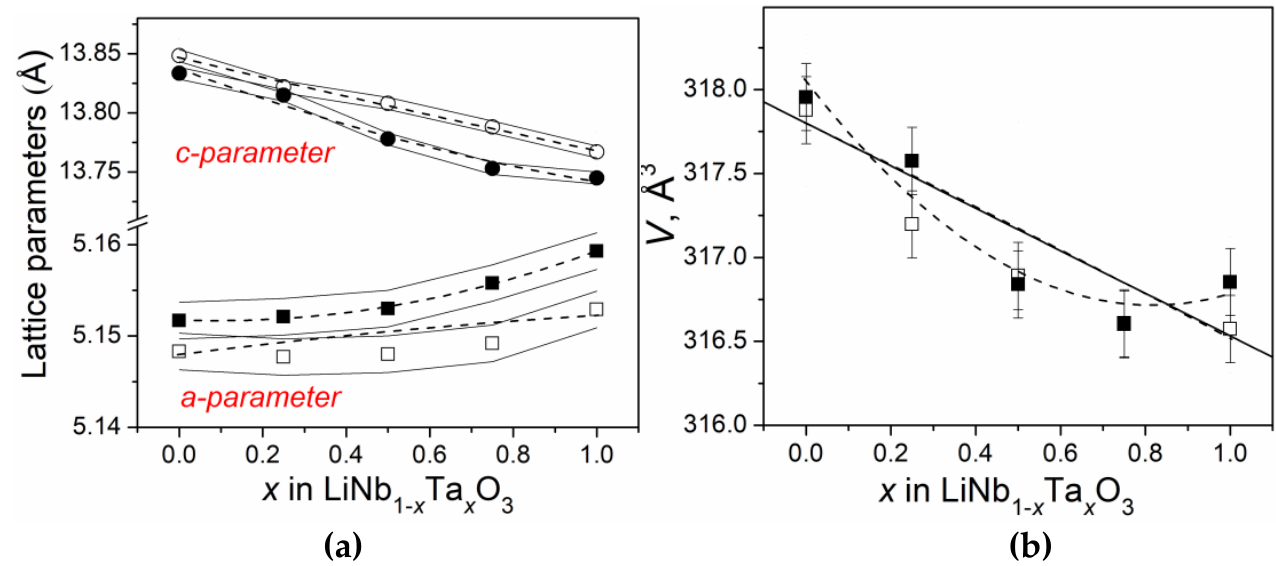
Figure 7. Concentration dependence of the lattice parameters ( a ) and unit cell volume ( b ) in LiNb 1 − x Ta x O 3 @550 °C and LiNb 1 − x Ta x O 3 @800 °C series. The dashed lines are a guide for eyes (empty symbols—samples annealed at 550 °C; solid symbols—samples annealed at 800 °C).